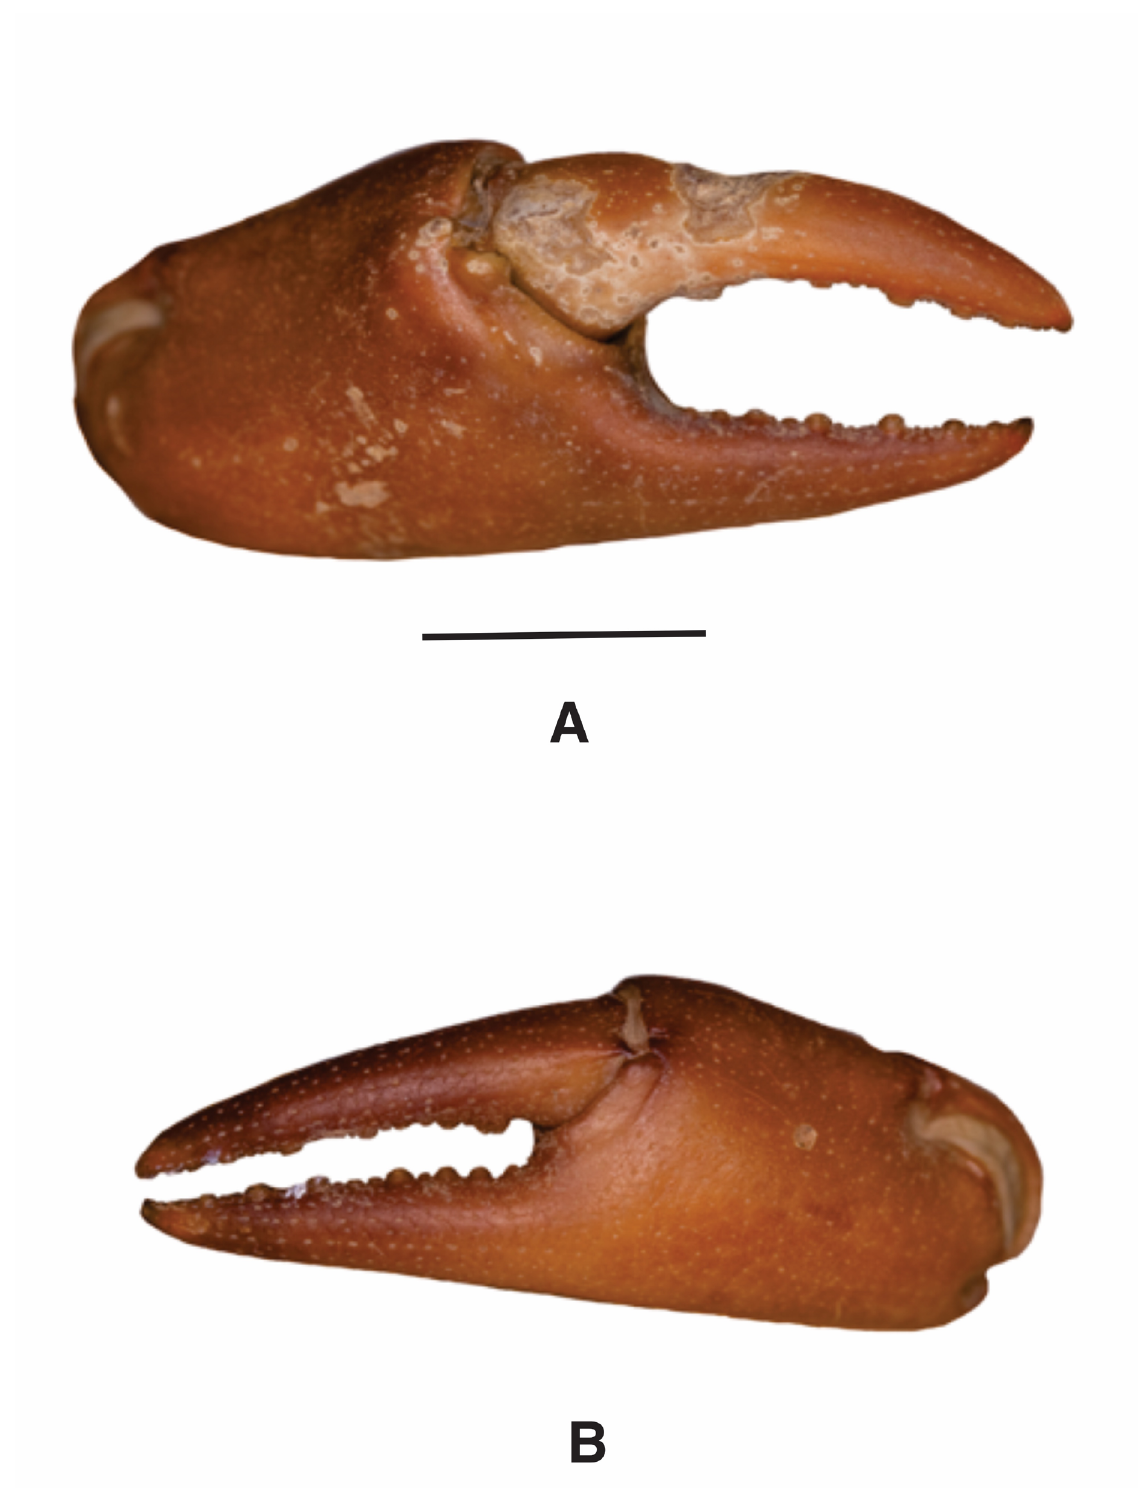
Fig. 8. Potamonautes baziya sp. nov., ♂, holotype, (SAM A-094474) A . Major right cheliped. B . Minor left cheliped. Scale bar = 10